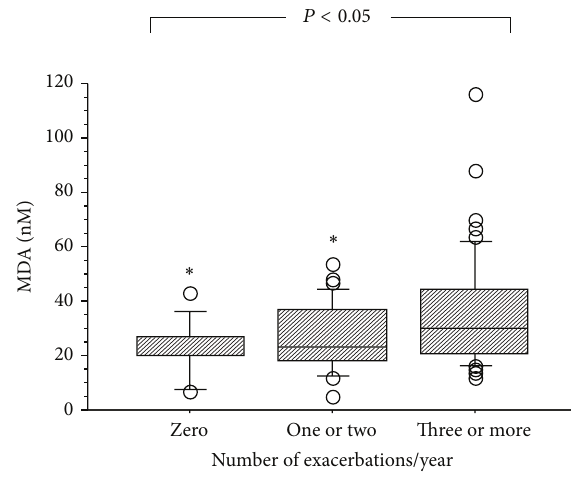
Figure 2: Box plots of malondialdehyde (MDA) in EBC according to the number of exacerbations in the preceding year. ∗ 𝑃 < 0.05 by Dunn-Bonferroni post hoc